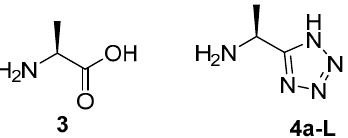
Figure 2. Alanine ( 3 ) and a tetrazole containing bioisostere 4a - L , designed as the basis for a series of potential AlaR inhibitors.